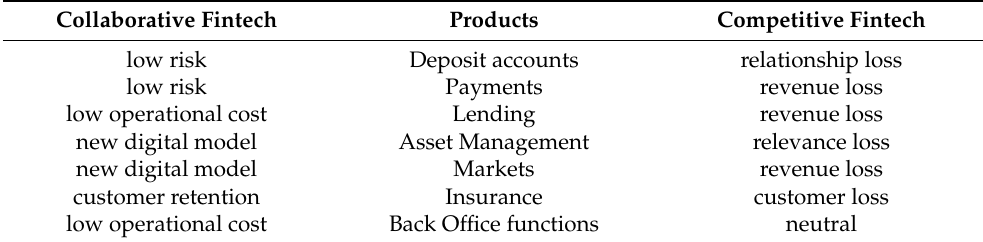
Table 2. Effect of strategic alliance of fintech on financial products.